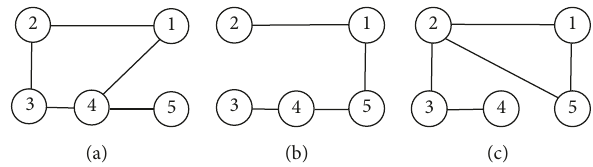
Figure 1: The structure of switching topology with 3 fixed and undirected graphs.